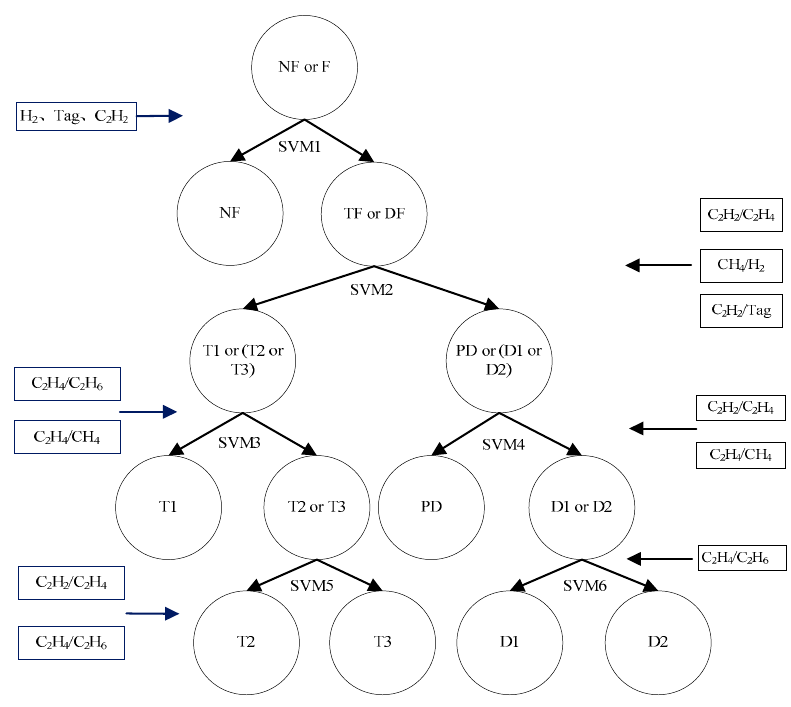
Figure 3. TWSVM neural network design and training flowchart.